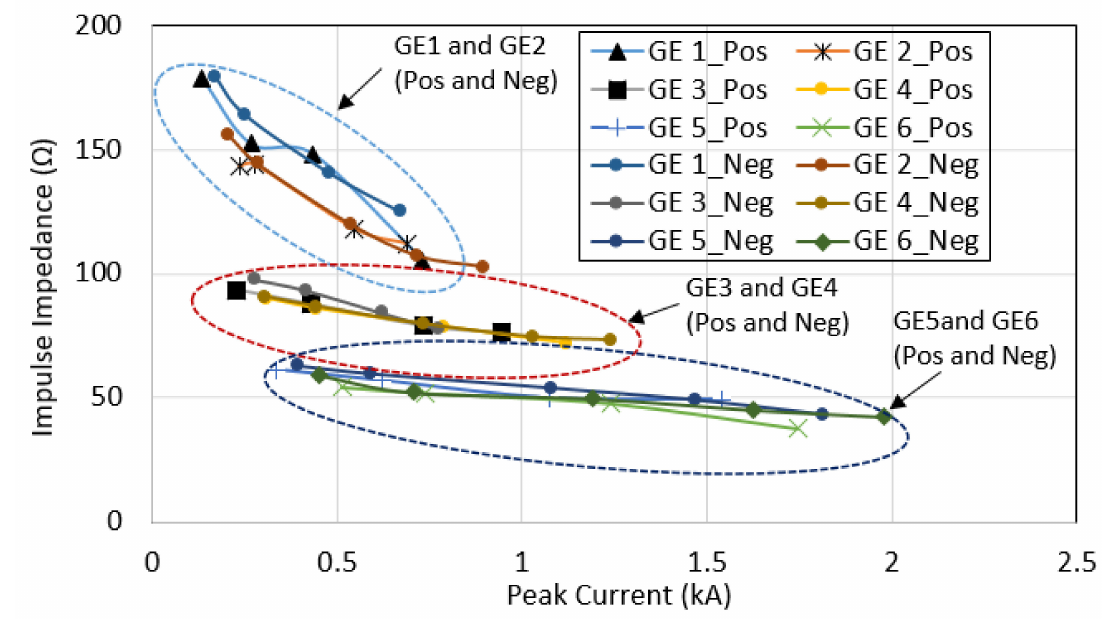
Figure 8. Impulse impedance for GEs at various peak current magnitudes. Table 2. Percentage drop of Z imp values from its R DC